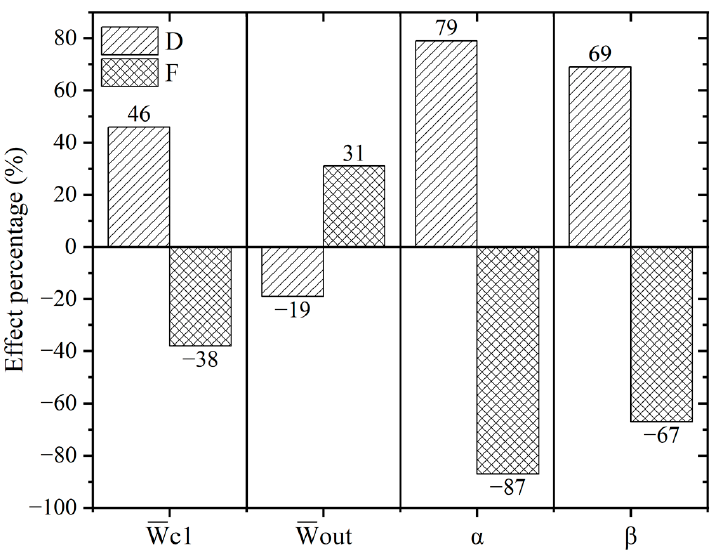
Figure 7. Sensitivity analysis.